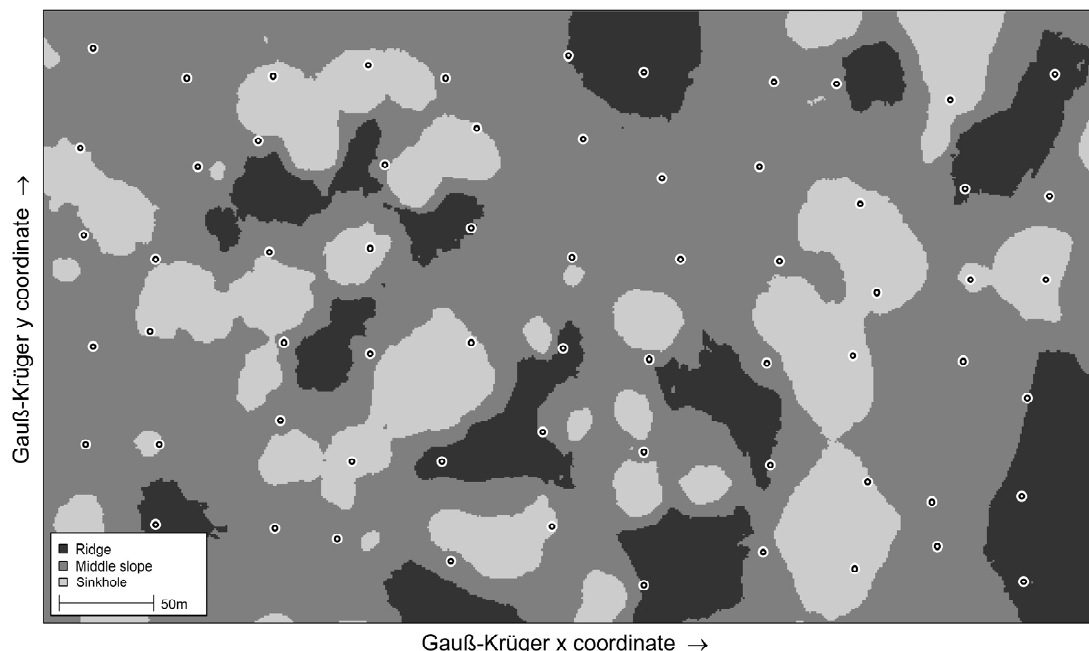
7 Figure 7. Spatial model of topographic conditions based on differences in the two models of silver fir tree dominant height and optimal moving window size in the high karst study area. Circles indicate stump positions of the investigated silver fir trees that grew on different landform